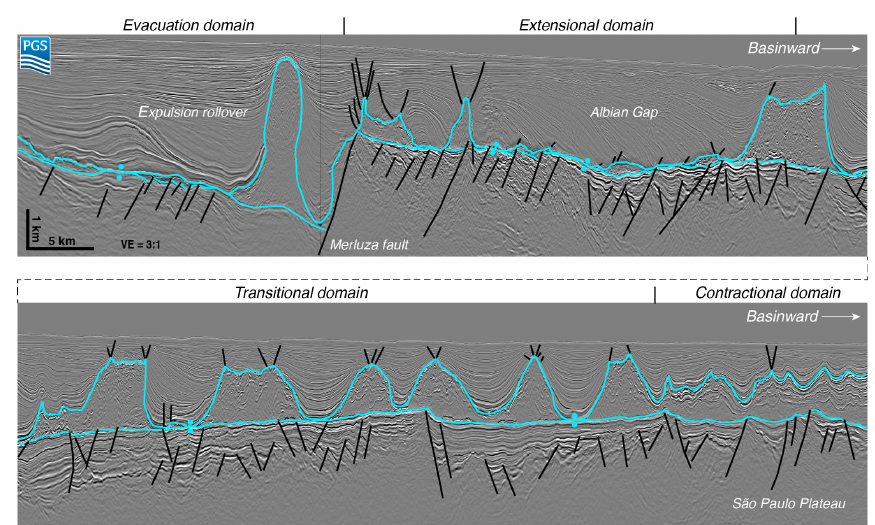
Figure 17. Regional 3-D depth-migrated seismic profile from the Santos Basin (vertical exaggeration 3 : 1), separated into two halves and with salt shown in cyan (data courtesy of PGS Investigação Petrolifera